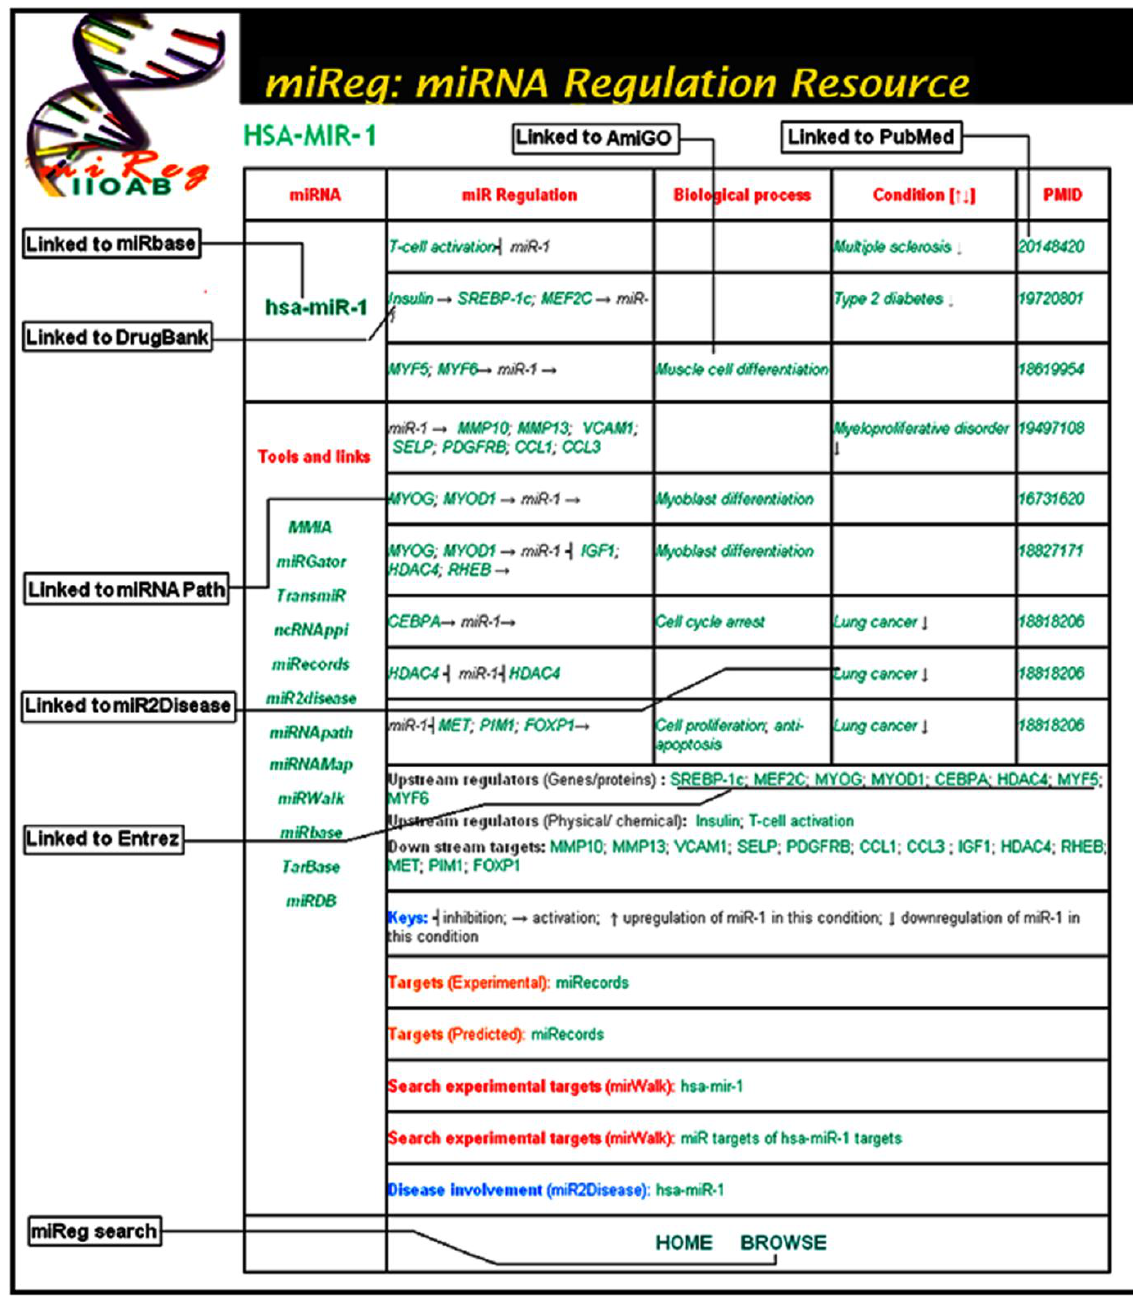
Figure 1: Snapshot of has-mir-1 page from miReg . The page shows miR-1 specific reactions, various upstream regulators of miR-1 and its targets, specific BPs, and experimental conditions along with corresponding PMID, reaction summery table, different web browsing options, and various external tools, links, and miRNA